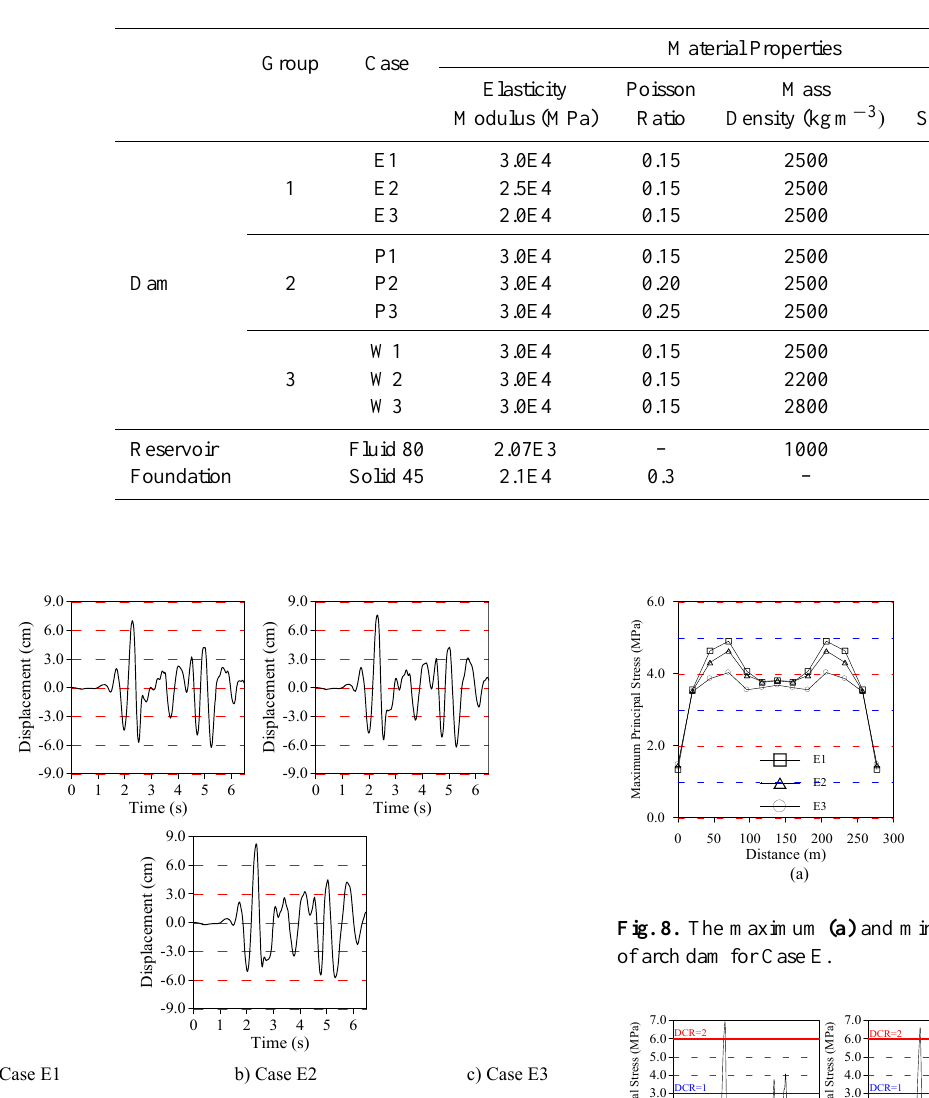
Fig. 7. The time histories of displacements at the nodal point 48 of arch dam for Case E. The variation of maximum and minimum principal stresses along I-I section (Fig. 4) are plotted in Fig. 8 for each case. It can be seen from Fig. 8 that the highest maximum and minimum principal stresses obtained from Case E1, E2, and E3, respectively. The maximum principal stresses are similar in abutment and middle parts of the dam. However, the minimum principal stresses are similar only in abutment parts, but the highest stresses occur in middle parts of the dam for Case E1, E2, and E3, respectively.